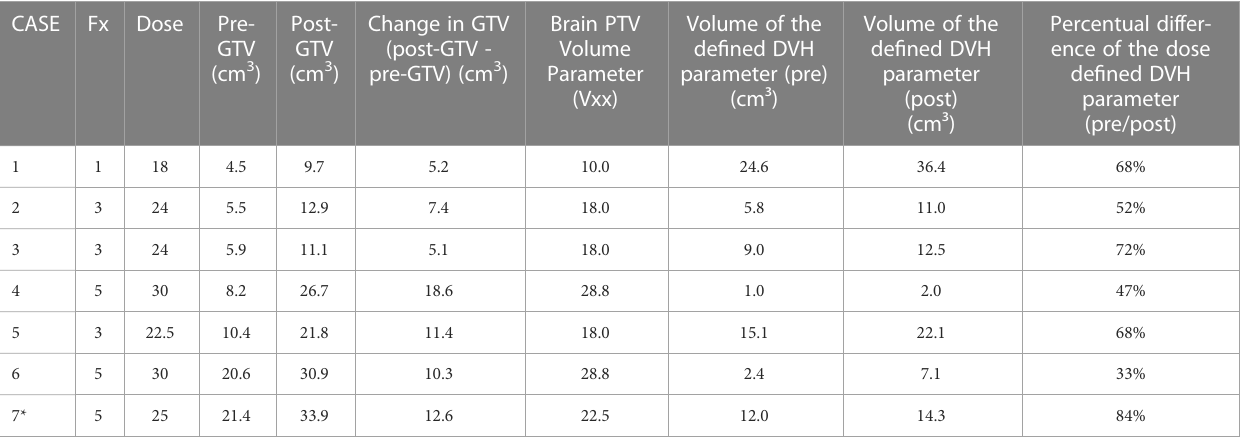
TABLE 4 Simulation planning details.